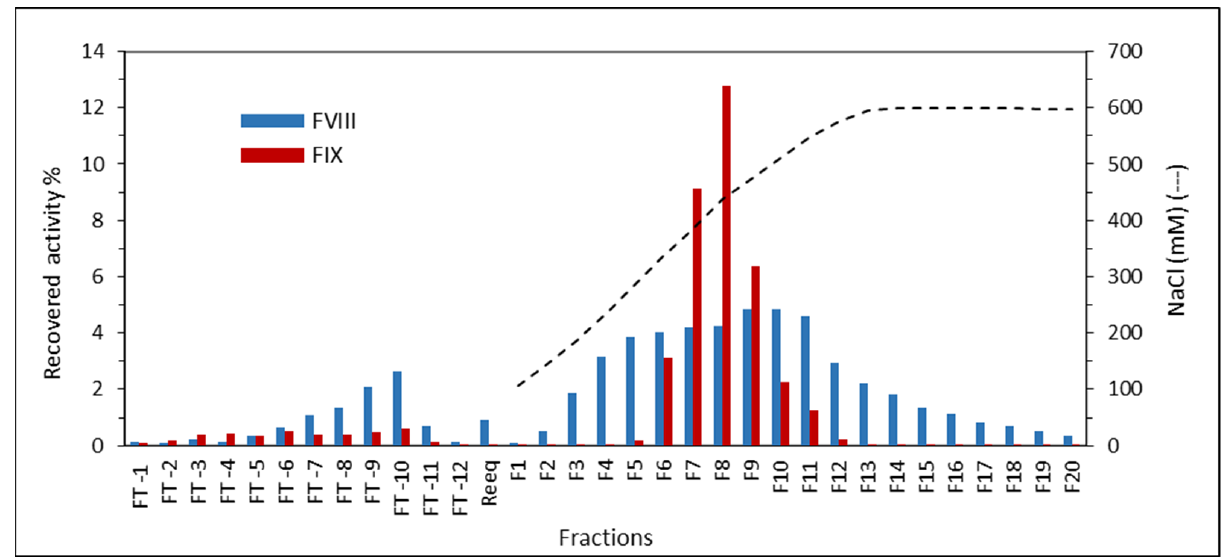
Figure 5. FVIII and FIX dynamic binding capacity and NaCl elution in purification of plasma on ANX Sepharose FF.